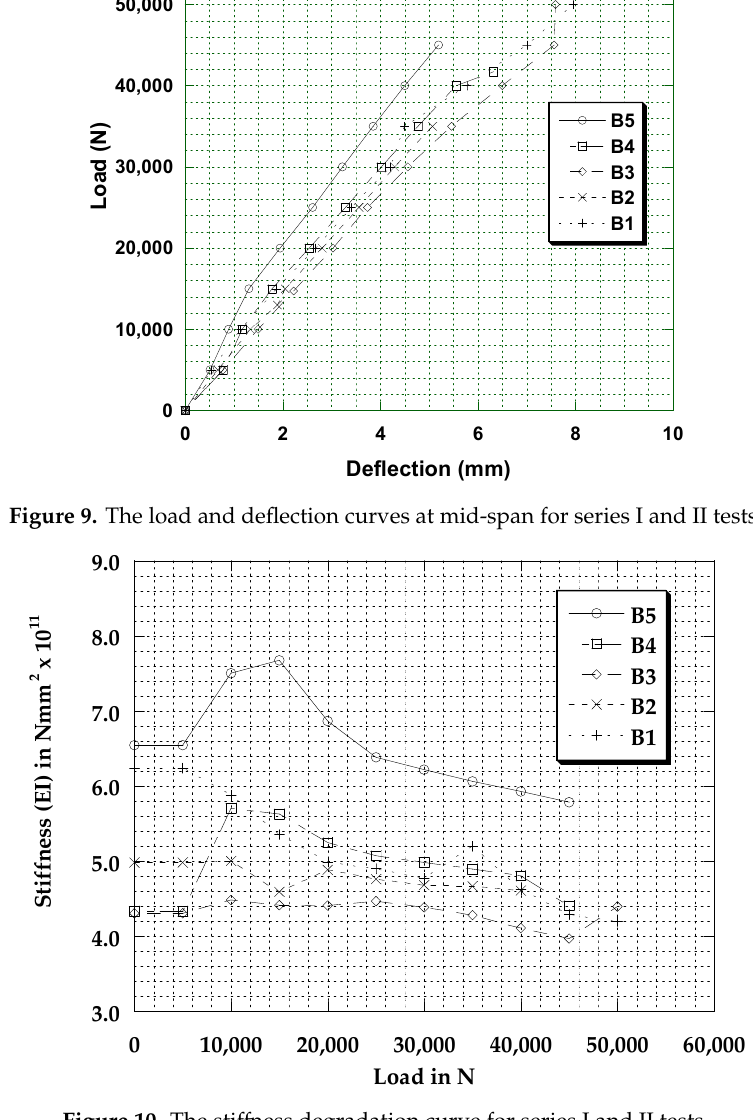
Figure 10. The sti ff ness degradation curve for series I and II Figure 10. The stiffness degradation curve for series I and II tests.